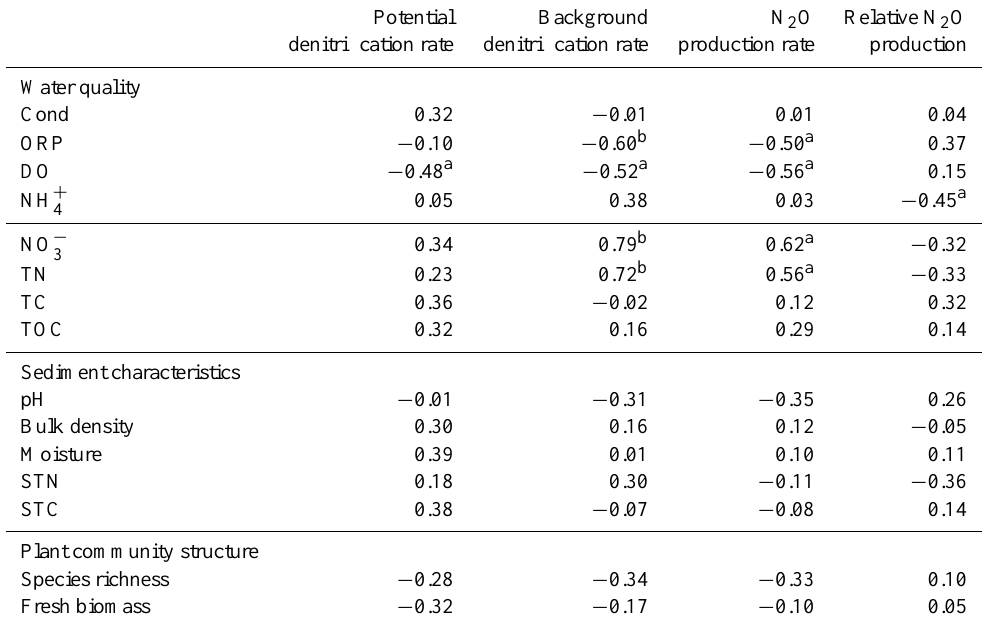
Table 3. Pearson correlation coefficients between sediment denitrification variables and within-lake characteristics ( N =